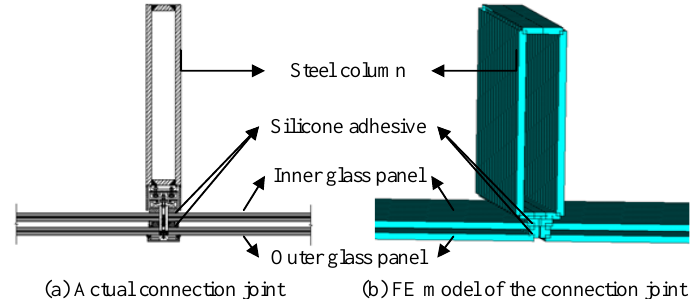
Figure 2. The connection joint of the LGCW. In the actual structure, the top and bottom of the LGCW are connected to the crossbeams (BEAM 44) with the silicone adhesive, the crossbeams are connected to steel columns through bolts, and the steel columns are connected to the high-rise building through bolts. In the FE model of the independent LGCW, the silicone adhesive and crossbeams are established at the top and bottom edges of the inner and outer glass panels, and the nodes of the silicone adhesive are coupled with the nodes of the crossbeams to simulate the elastic constraints between the crossbeams and glass panels, as shown in Figure 3. The crossbeams and columns use the same node at the intersection points. The top and bottom of the steel columns are sliding and fixed hinges, respectively, where the rotation degrees are restrained for each hinge. The dimensions of the independent LGCW are 15 m in height, 3 m in width between two columns, and 20 mm in thickness for both outer and inner glass panels. The thicknesses of the silicone adhesives are 27 mm between outer and inner glass panels, 37 mm between inner glass panels and columns, and 20 mm between inner glass panels and crossbeams. The dimensions of the rectangular columns are 580 mm × 130 mm × 20